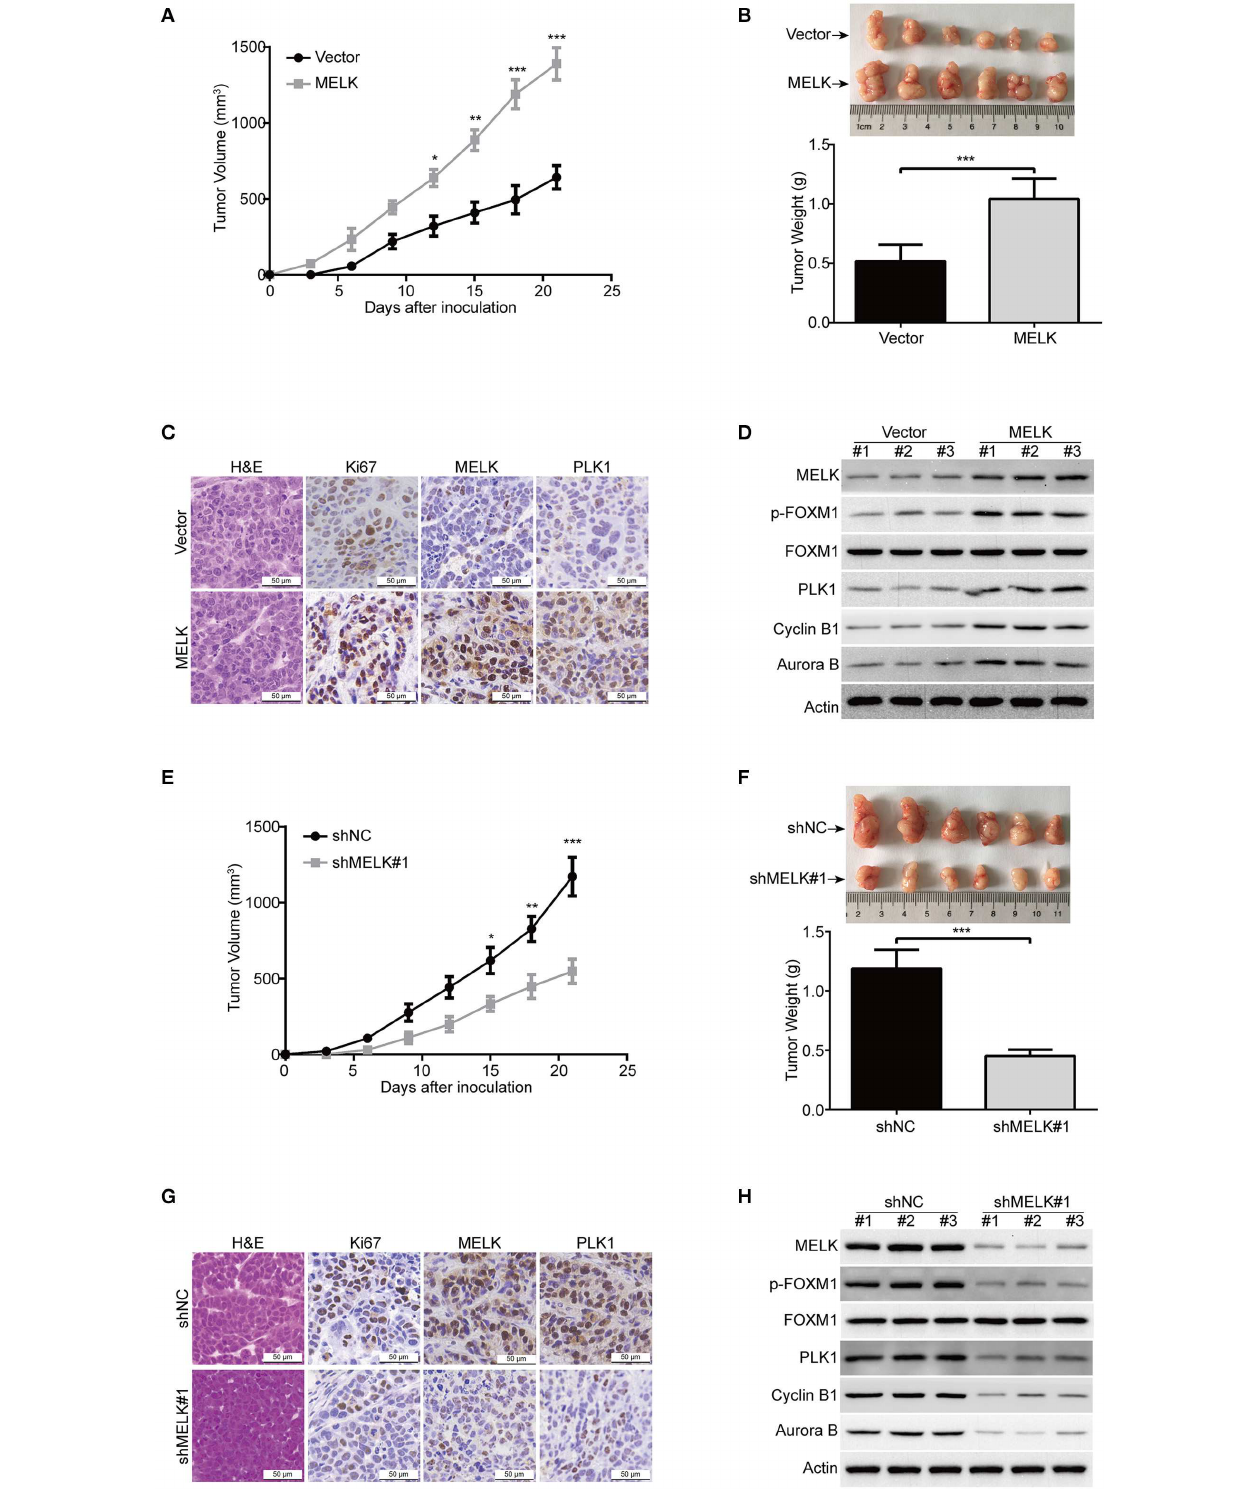
FIGURE 5 | MELK promotes ESCC cell growth in nude mice. (A) The growth curves of subcutaneous xenografts of MELK-overexpressing EC109 cells are shown. Data represents mean ± SD. (B) Upper, representative tumors derived from EC109 cells with or without MELK overexpression are presented; Lower, comparison of tumor weights in control (Vector) and MELK-overexpressing group ( n = 6). (C) Immunohistochemical analysis of Ki67, MELK, and PLK1 in xenograft tissues from